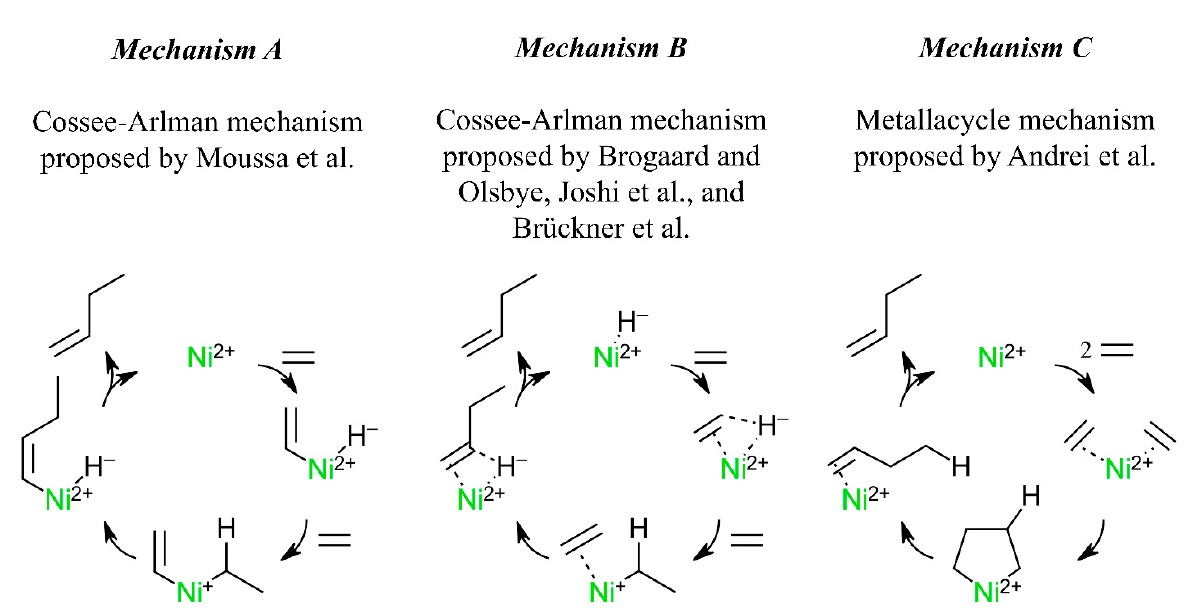
Figure 1. Simplified reaction mechanisms proposed in the literature (adapted from Moussa et al. [5], Brogaard and Olsbye et al. [28], Brückner et al. [37], and Joshi et al. [31,33]) for ethylene oligomerization over nickel-based solid catalysts. Mechanisms A and B are based on the Cossee–Arlman mechanism, and Mechanism C is based on the metallacycle mechanism.